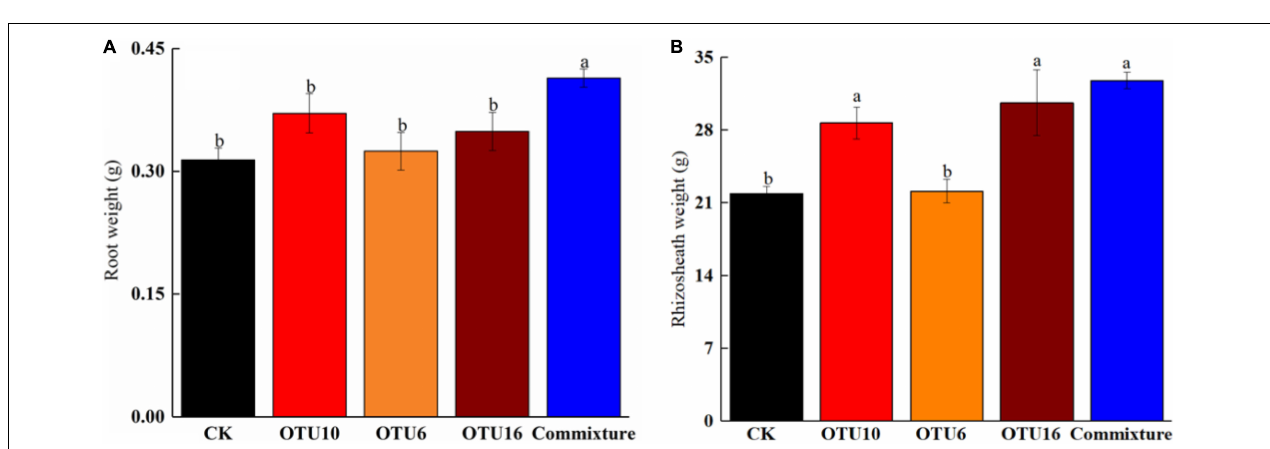
FIGURE 5 | Asymmetrical distribution of operational taxonomic units (OTUs) in the unsterilization soils and sterilization soils. Cumulative histogram of the top 30 bacterial OTUs isolated from Kengyilia hirsuta rhizosheaths in unsterilized soil (A) . Cumulative histogram of the top 30 bacterial OTUs isolated from Kengyilia hirsuta rhizosheaths in sterilized soil (B) . Number of OTUs present under different soil sterilization treatment conditions (C) . The relative abundance of each OTU, depicted in red (from sterilized soil) or blue (from sterilized soil), is expressed as the log2(x + 1)-transformed number of sequencing reads from a given isolation source.